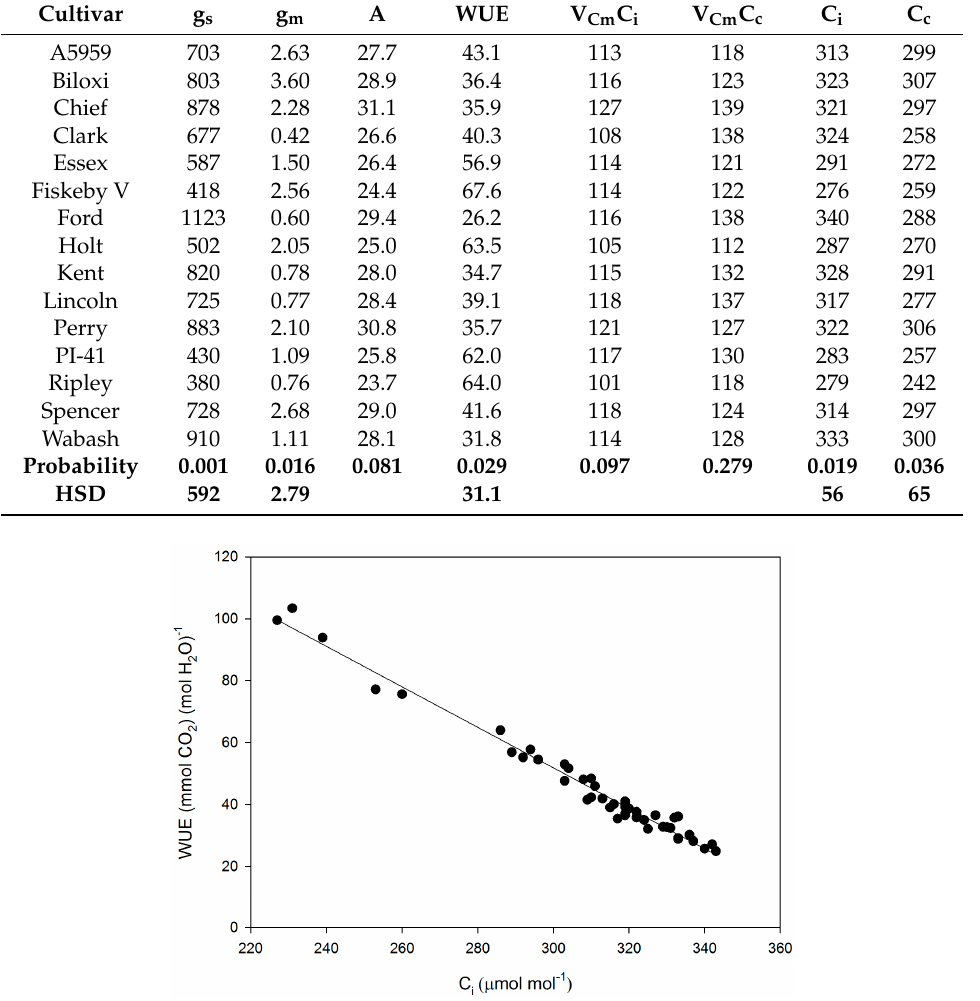
Figure 2. Leaf intrinsic water use efficiency (WUE) as a function of sub-stomatal CO 2 concentration (C i ) for all measurements made on fifteen cultivars of soybean. The linear regression: WUE = 248 − 0.654 × C i had an r 2 of 0.98. Mesophyll conductance had no significant correlation with intrinsic WUE (r = − 0.047), g s (r = +0.065), A (r = +0.234), or V Cmax C i (r = +0.227) (Figure 3). Using means for the cultivars for all of